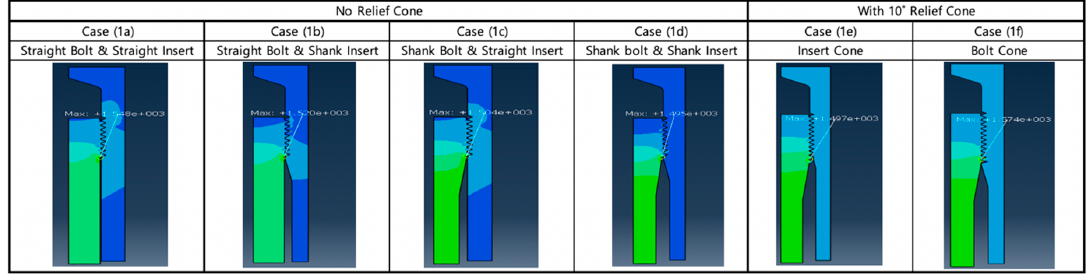
Figure 14. 2D bolt joint models with varying parameters (straight/shank and with/without a relief cone).